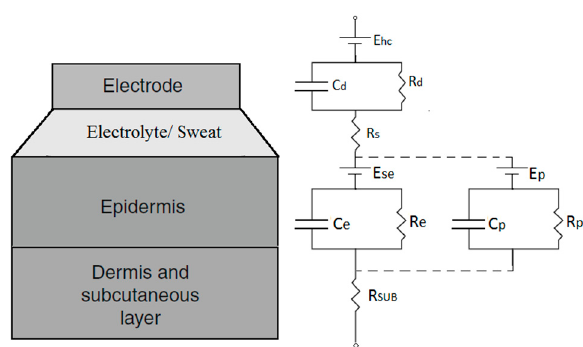
Figure 1. The electrical equivalent circuit of the skin-electrode interface [29].